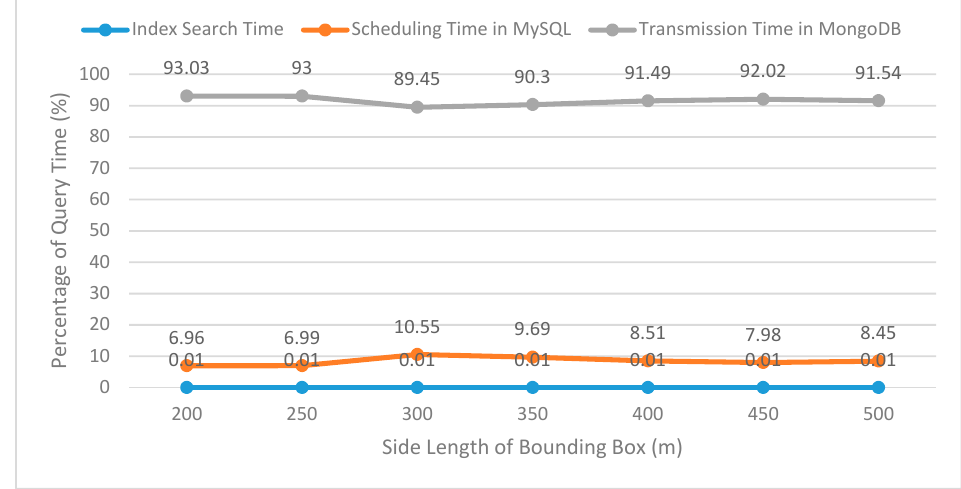
Figure 8. The query times for GeoVideo MVO at different stages.